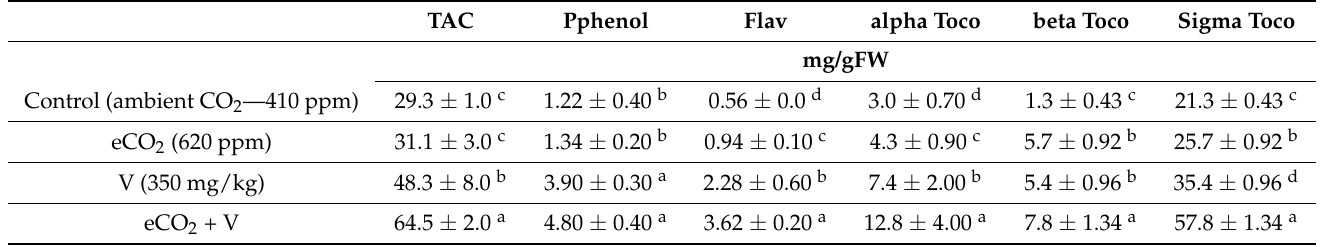
Table 3. Effect of elevated CO 2 (eCO 2 ), vanadium (V) and their combination (eCO 2 + V) on non- enzymatic antioxidant of wheat. total antioxidant capacity (TAC), Polyphenol (Pphenol), flavonoid (Flav) and. Data are mean values ± SE ( n = 4). Using Fisher’s LSD test, the data for each group were compared pairwise ( p < 0.05; n = 4). Different letters indicate that there is a significant difference between the treatments. TAC Pphenol Flav alpha Toco beta Toco Sigma Toco mg/gFW